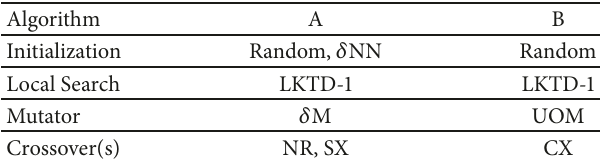
Table 1: Genetic algorithms used for computational study. Algo- rithm A is our best combination of operators and Algorithm B is the best found in the literature